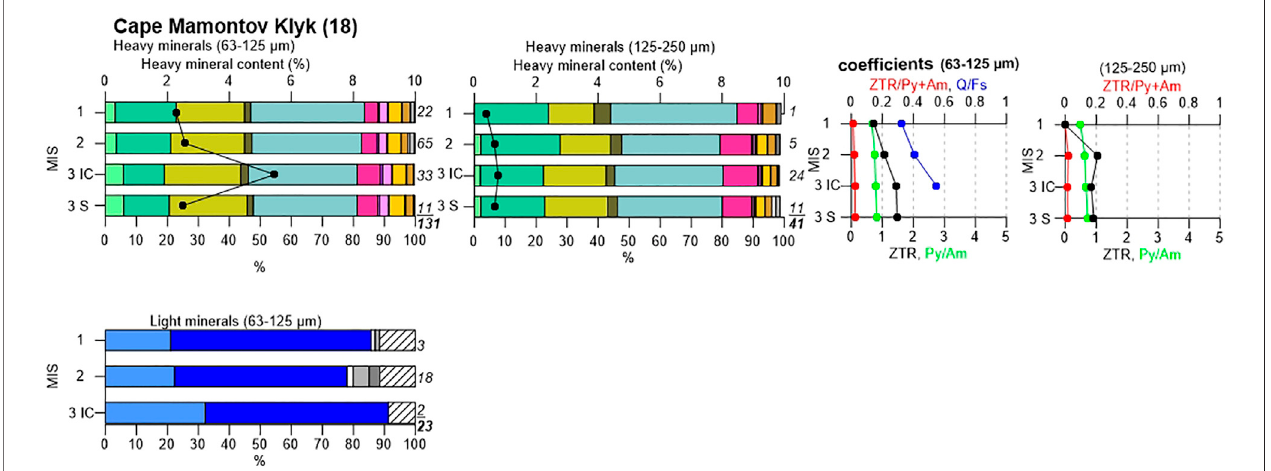
FIGURE 6 | Heavy and light mineral associations of the 63 – 125 μ m and 125 – 250 µm fraction, the heavy mineral contents, and the corresponding mineral coef fi cients from Cape Mamontov Klyk (18). The number of samples is in italics to the left of each diagram (Note the larger scales for heavy mineral contents and some mineral coef fi cients than in previous fi gures). For the legend, see Figure 2